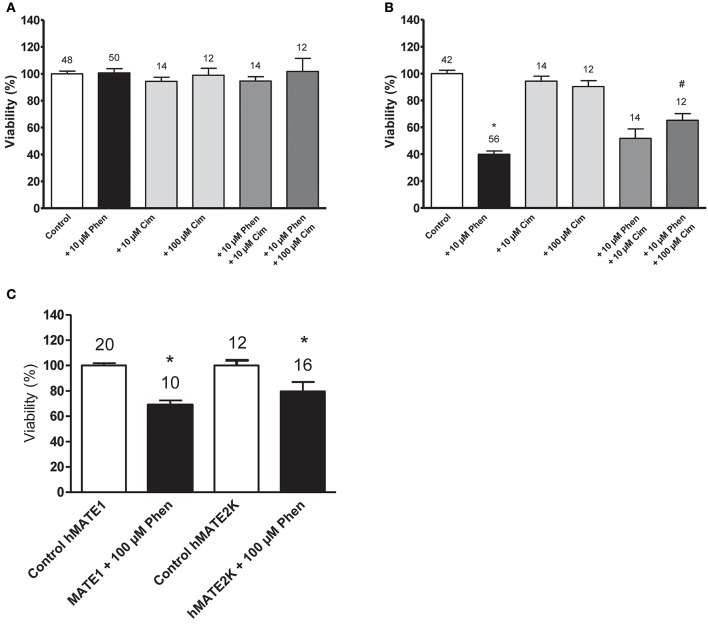
Cell viability (EC50) determined by MTT assay for cells incubated with buffer (control); 10 μM phenanthriplatin (Phen); 10 μM cimetidine (Cim); 100 μM cimetidine; 10 μM phenanthriplatin + 10 μM cimetidine; and 10 μM phenanthriplatin + 100 μM cimetidine, for 10 min. (A) HEK 293 WT cells (B) HEK 293 hOCT2 cells (C) HEK293 hMATE1 and hMATE2K cells. Above the columns is the number of experiments. The asterisk (*) indicates a statistically significant difference compared to the other columns, #a statistically difference compared to all the other columns except than to 10 μM phenanthriplatin + 10 μM cimetidine (ANOVA).